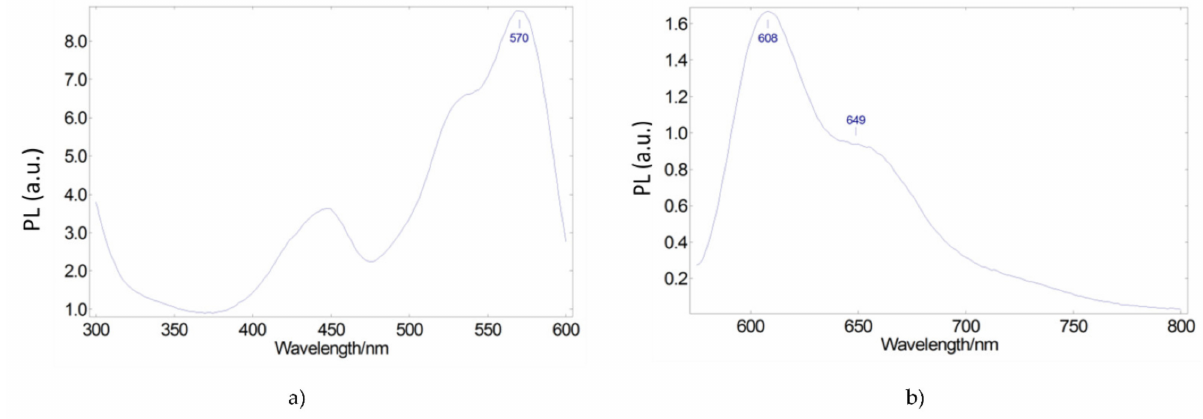
Figure 4. Photoluminescent excitation ( a ) and emission ( b ) spectra of Lumogen Red red-emitting converter embedded in a PMMA